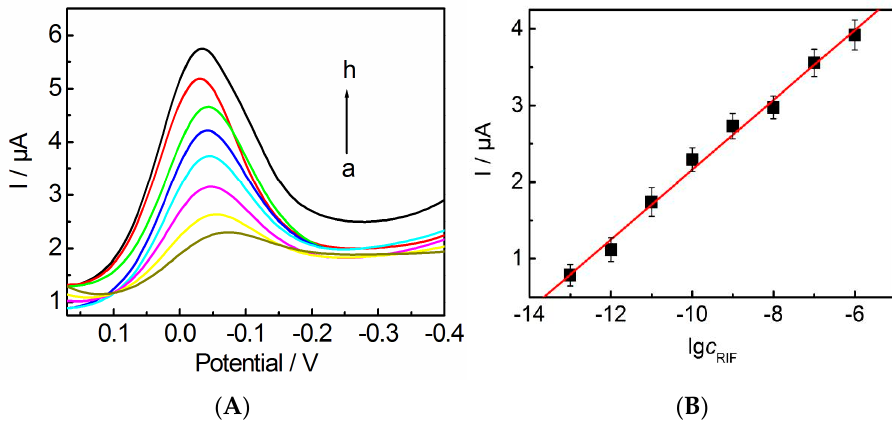
( A ) ( B ) Figure 6. ( A ) DPVs of the di ff erent concentrations of RIF at MWCNTs-CeO 2 nanorods / GCE in 0.1 mol / L PBS (pH = 7.0); ( B ) The reduction peak current vs. the concentration of RIF. a—1.0 × 10 − 13 , b—1.0 × 10 − 12 , c—1.0 × 10 − 11 , d—1.0 × 10 − 10 , e—1.0 × 10 − 9 , f—1.0 × 10 − 8 , g—1.0 × 10 − 7 , h—1.0 × 10 − 6 mol / L. Table 1. Comparison of the linear ranges and detection limits of previous RIF sensors. Modified Electrode Linear Range (mol / L) Detection Limit (mol / L)